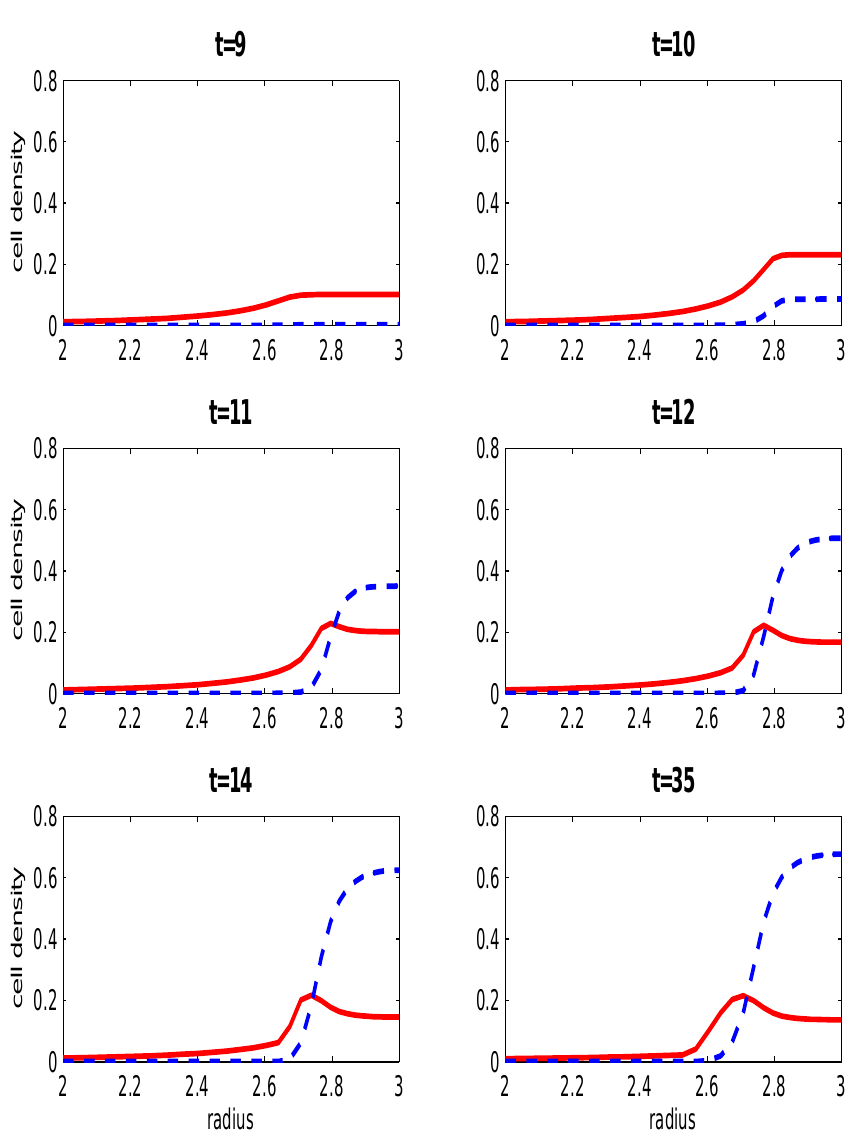
Figure 4. The numerical solutions ρ M ( r,t ) and ρ G ( r,t ) to (2.1)–(2.2), (2.5)–(2.7). Prolif- erating cells are denoted by solid lines and migrating cells by dashed